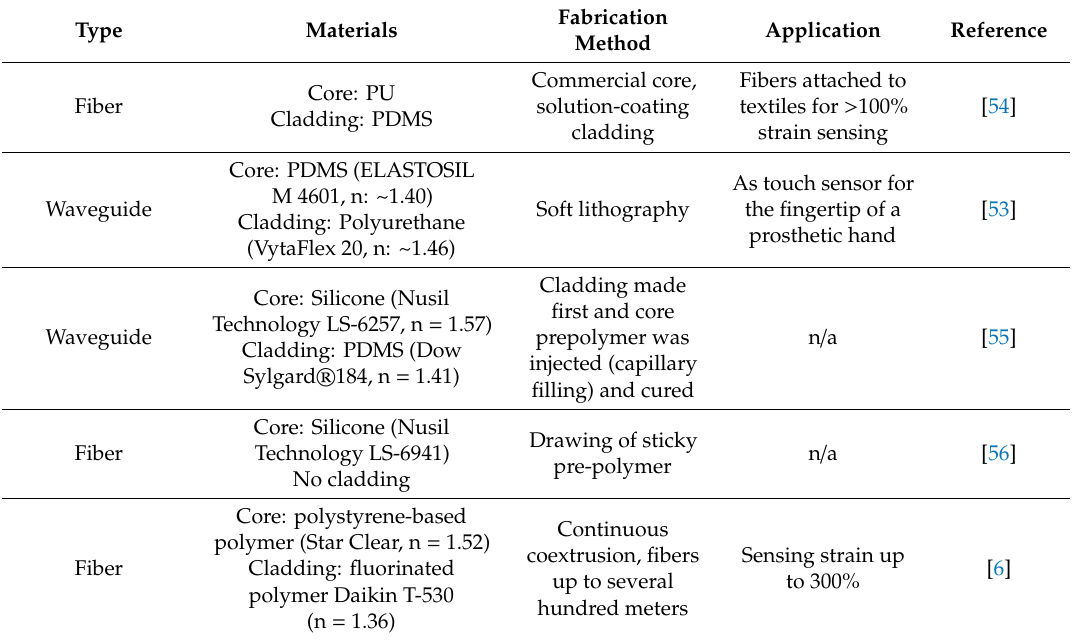
Table 2. PDMS-based optical fibers and